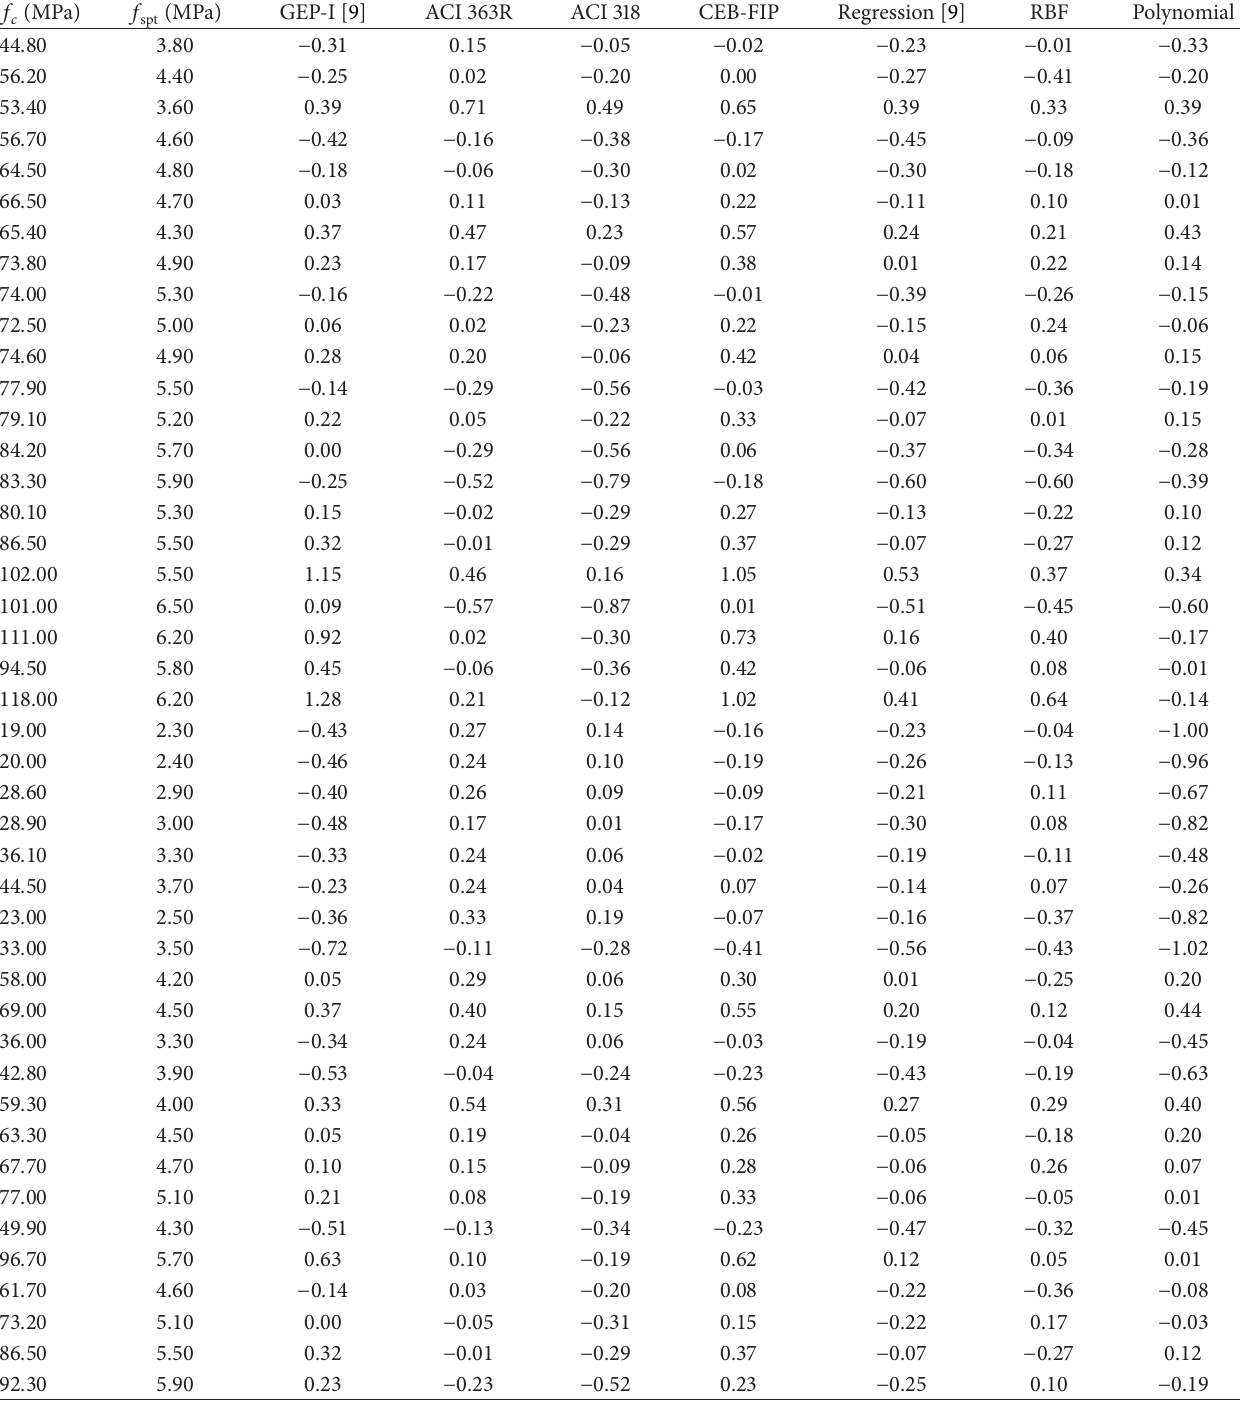
Table 3: Comparison of experimental results to testing results of RBF, polynomial of SVM-I, and other